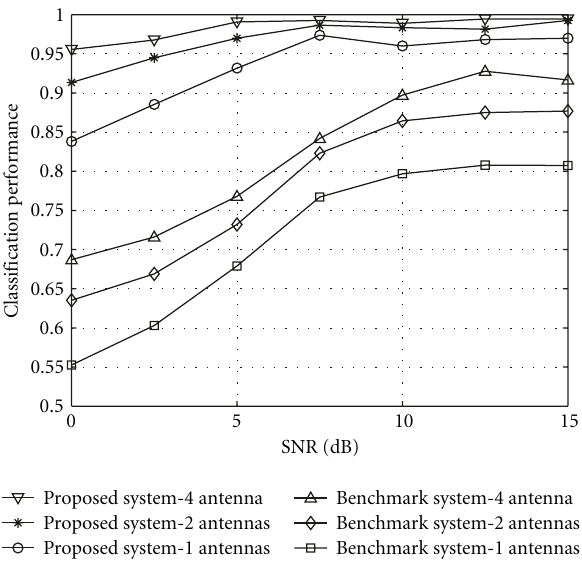
Figure 20: Ability of proposed classifier and benchmark to determine a signal’s modulation family in a faster varying flat fading channel using SC.